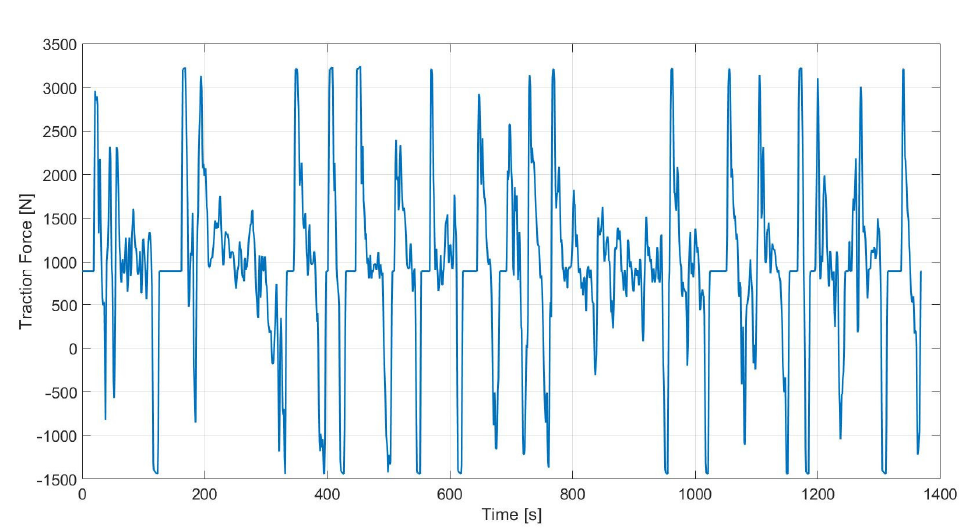
Figure 8. Drive Cycle and Traction Force.